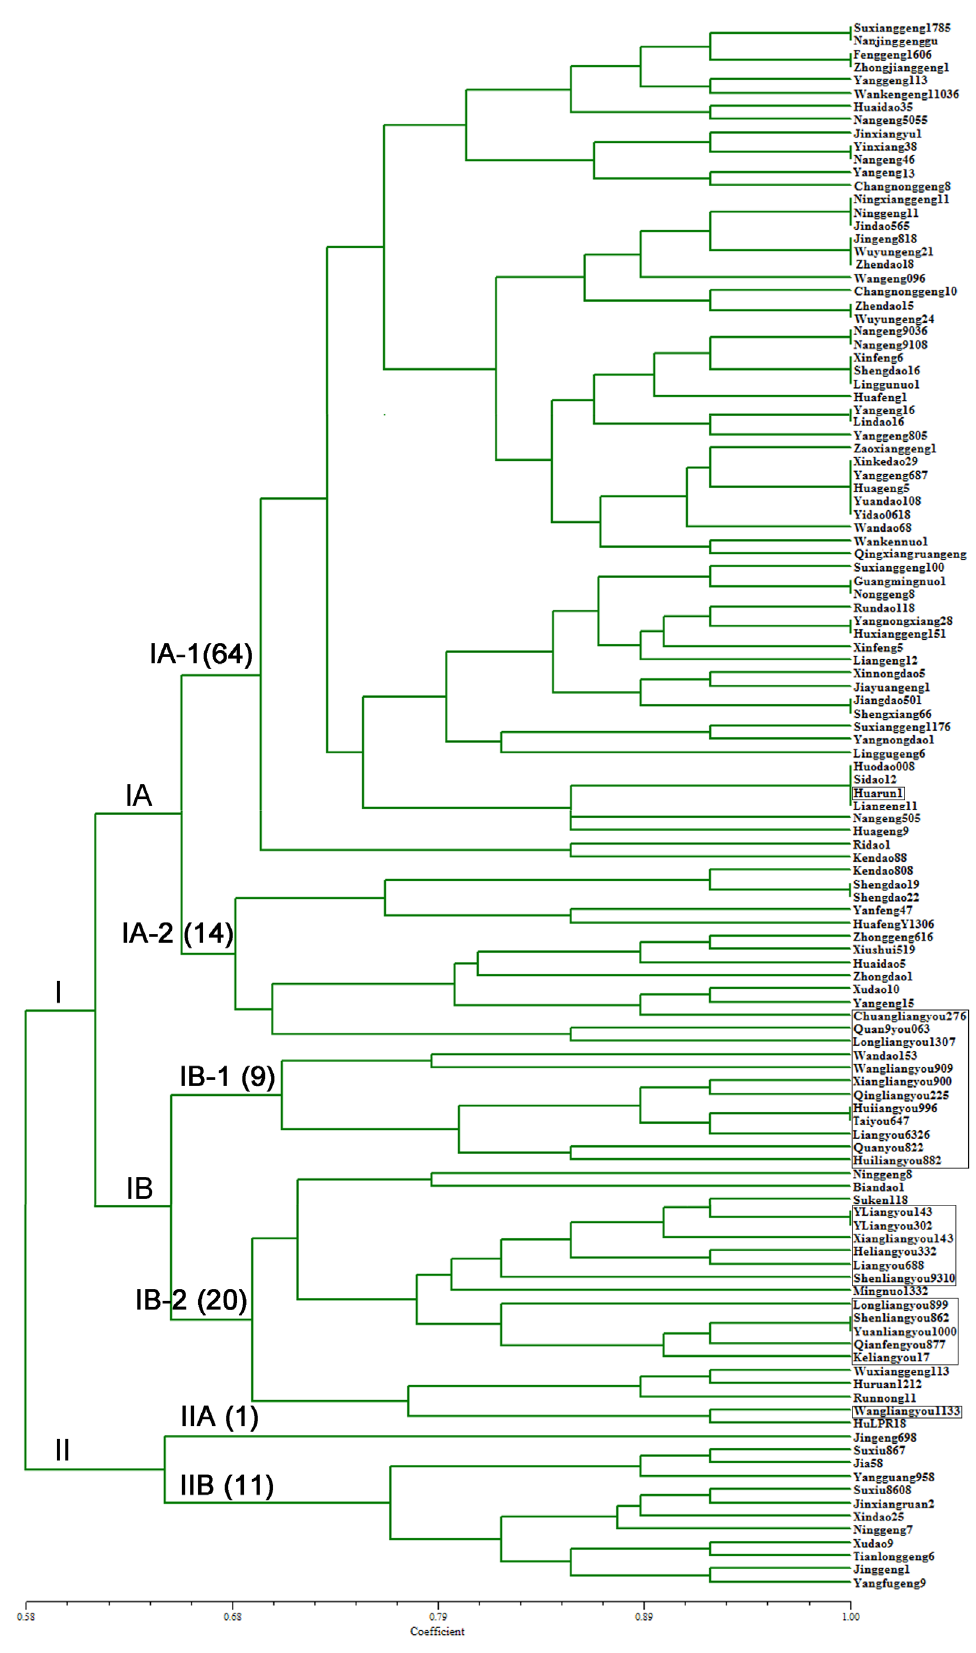
Figure 3. Clustered analysis of 119 rice main varieties on 14 R genes.